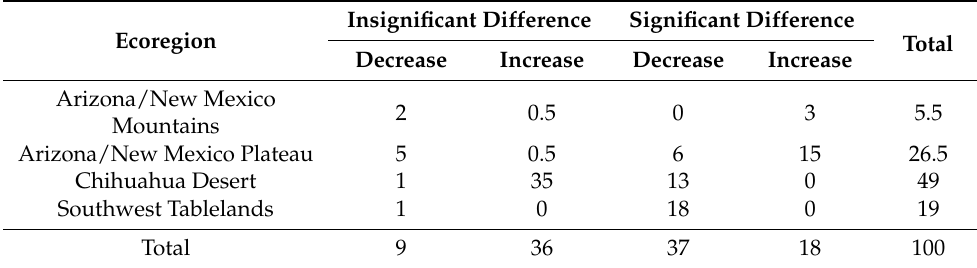
Table 4. The percentages of pixels with decreasing and increasing trends in productivity as estimated from the RPMS data relative to randomly selected pixels (155) based on the Segmented VPR method categorized based on their significance of difference in mean productivity before and after the break years over major ecoregions in New Mexico.